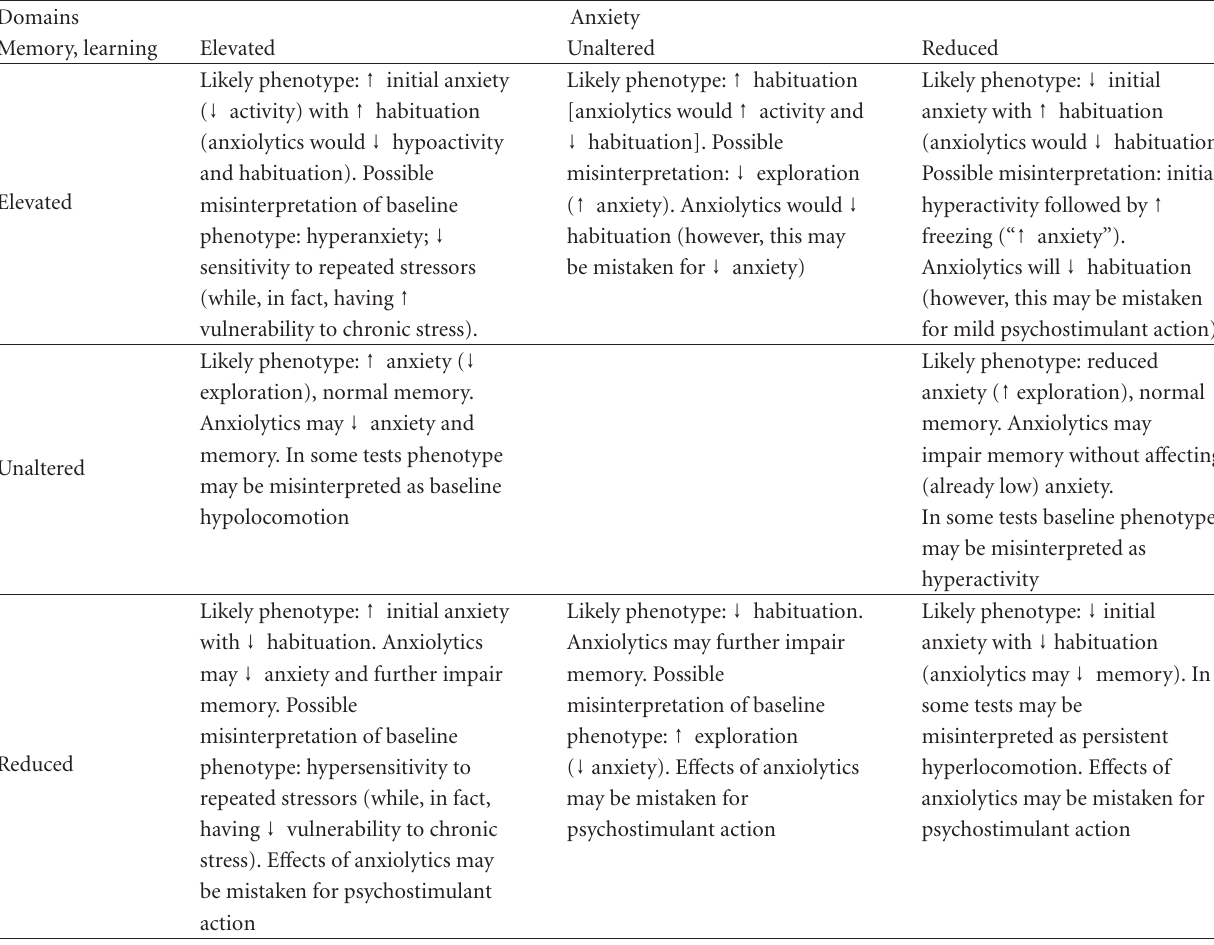
Table 1: Examples of possible interplay between memory and anxiety domains, and how this may lead to misinterpreted animal behavioral and drug-induced phenotypes (e ff ects: ↑ increased, ↓ reduced behavior). Note that real animal models have multiple other factors and domains, and the complexity (and risks of incorrect interpretation) of their phenotypes is much